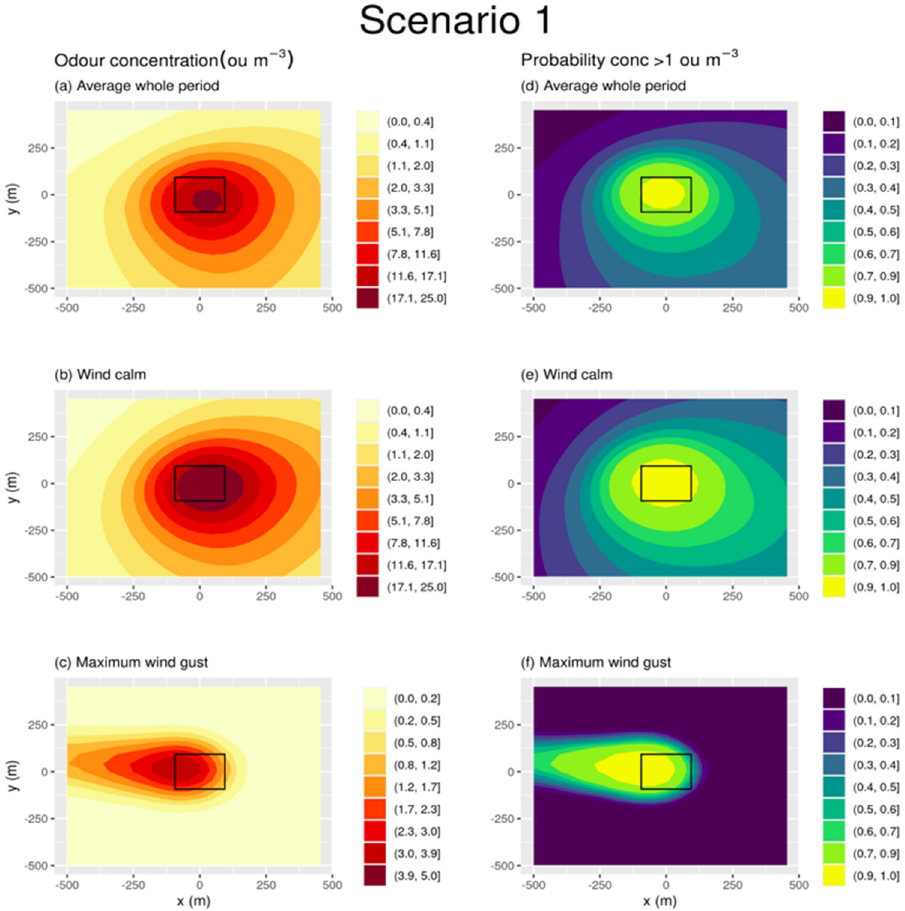
Figure 6. Odour concentrations (left panel) and exceedance probability of the 1 ou m − 3 threshold (right panel) at a 1.7 m height as simulated by SCICHEM for the period 1 October 2020–31 October 2020, for scenario 1. Modeled concentrations and probabilities are represented for the whole period ( a , d ), the episodes of calm winds ( b , e ), and the episodes of maximum wind gust ( c , f ). The square in the center represents the fertilized field (emission source), and the x and y coordinates are expressed as the distances in meters from the center of the source. Note: the color scale for the concentrations is different in the maximum wind gust event from the other two cases (average conditions, wind calm conditions).